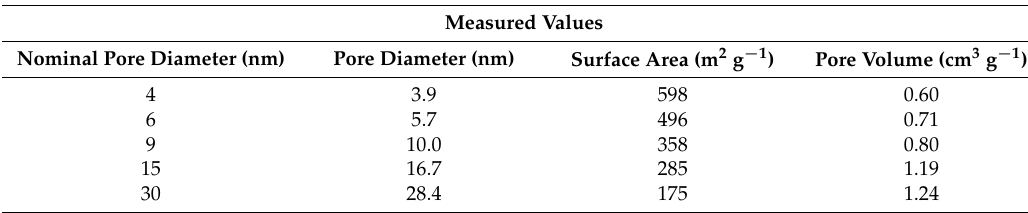
Table 1. Basic parameters of the porous